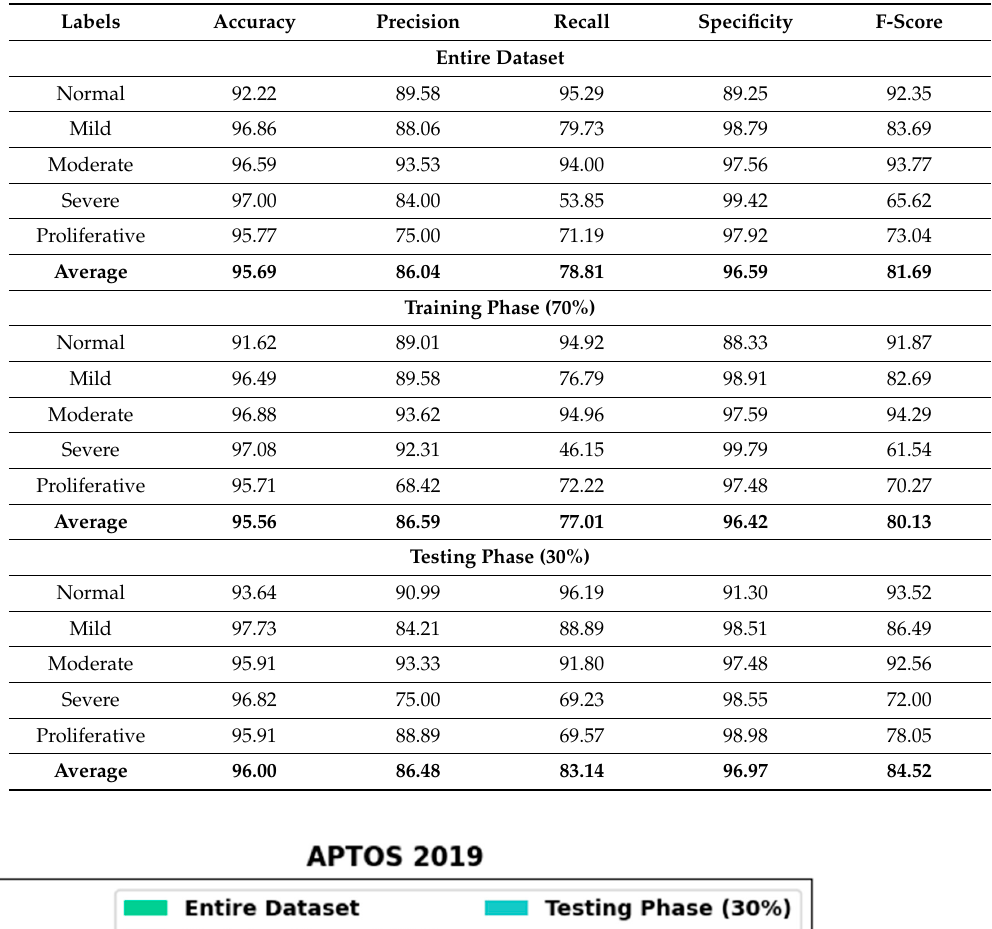
Table 2. Result analysis of the XAITO-DRGC approach with various measures on the APTOS 2019 dataset.